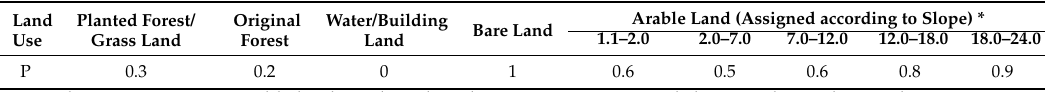
Table 1. The assignment of the conservation support practice factor based on land uses (P) in the study